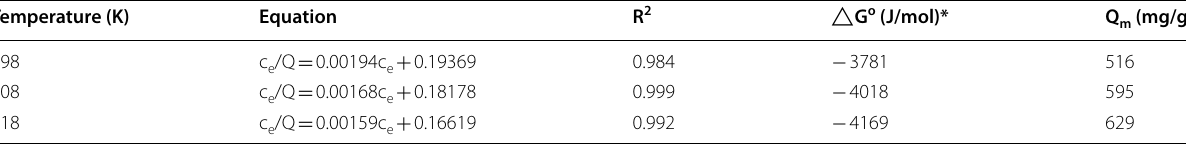
* △ G o calculated using data from 1,3-PDO standard solution at 25 g/L